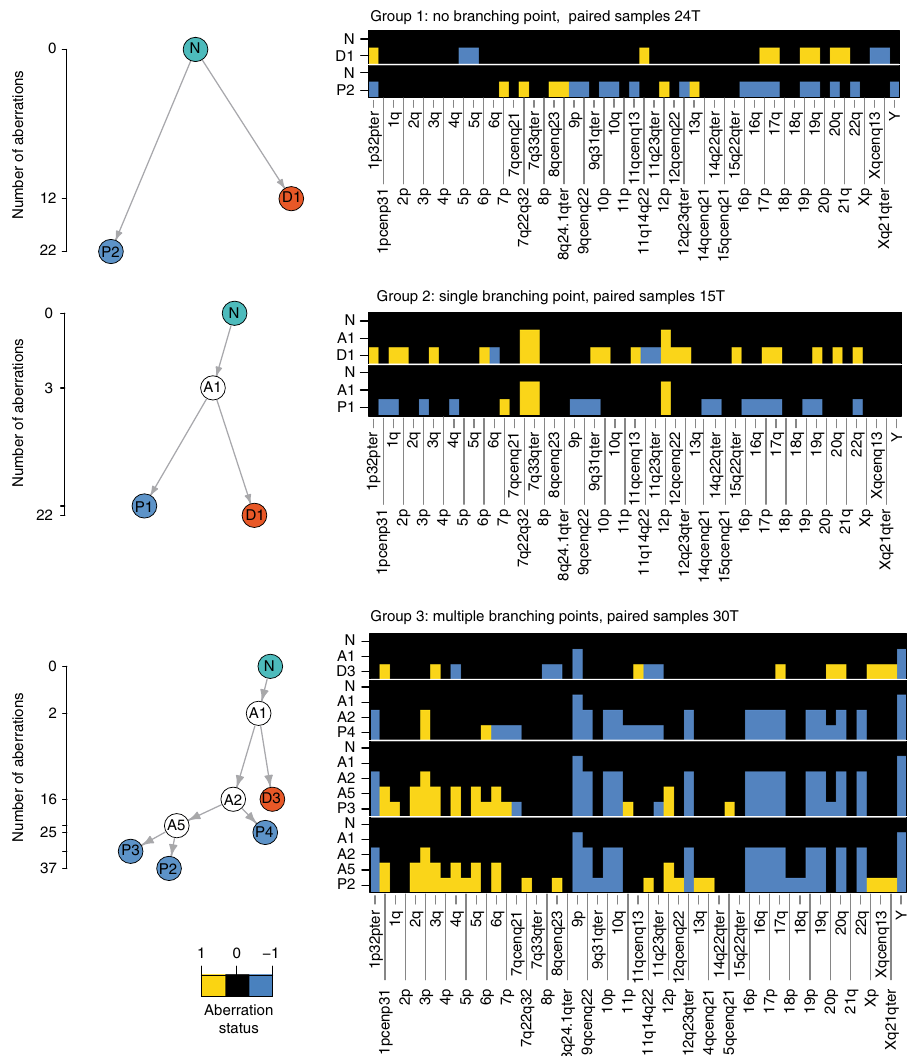
Fig. 3 Phylogenetic trees of paired PT and DCC samples. Representative examples for the three distinct groups observed in our data (for all 19 patients, see Supplementary Figures 6 – 8). The ordinate of the tree panels indicates the number of aberrations per CGH pro fi le (square root scale). Heat maps show aberration pro fi les along paths from normal cells (N) to PT (P1 – 4) and DCC (D1, D3) samples, respectively. Pro fi les A1, A2 and A5 denote inferred common ancestors (intermediates) (see 'Methods'